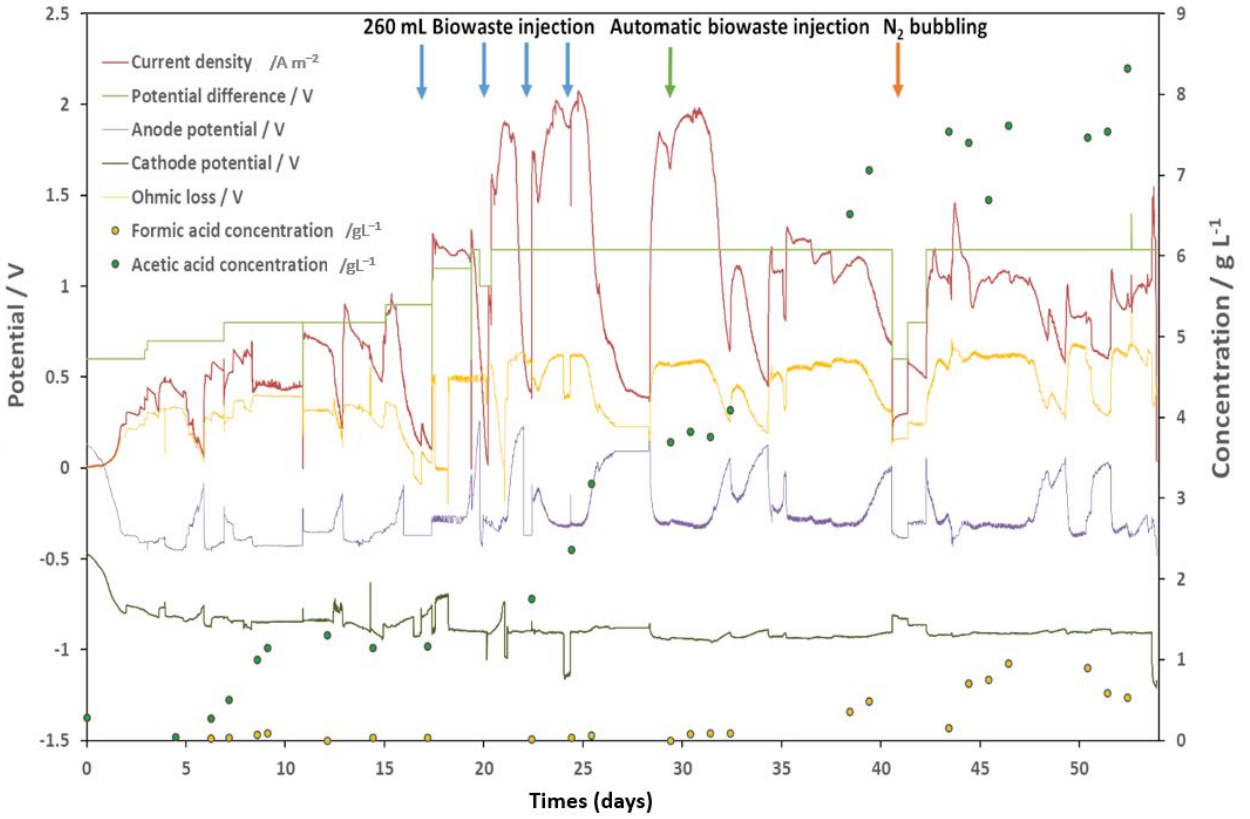
Figure 5. Performance synthesis of the TRL4 reactor. The y -axis on the left indicates the current density and the potential. The y -axis on the right indicates the concentration. Anode and cathode potentials versus Ag/AgCl electrodes were presented. Concentrations of VFAs detected in the IC are presented.